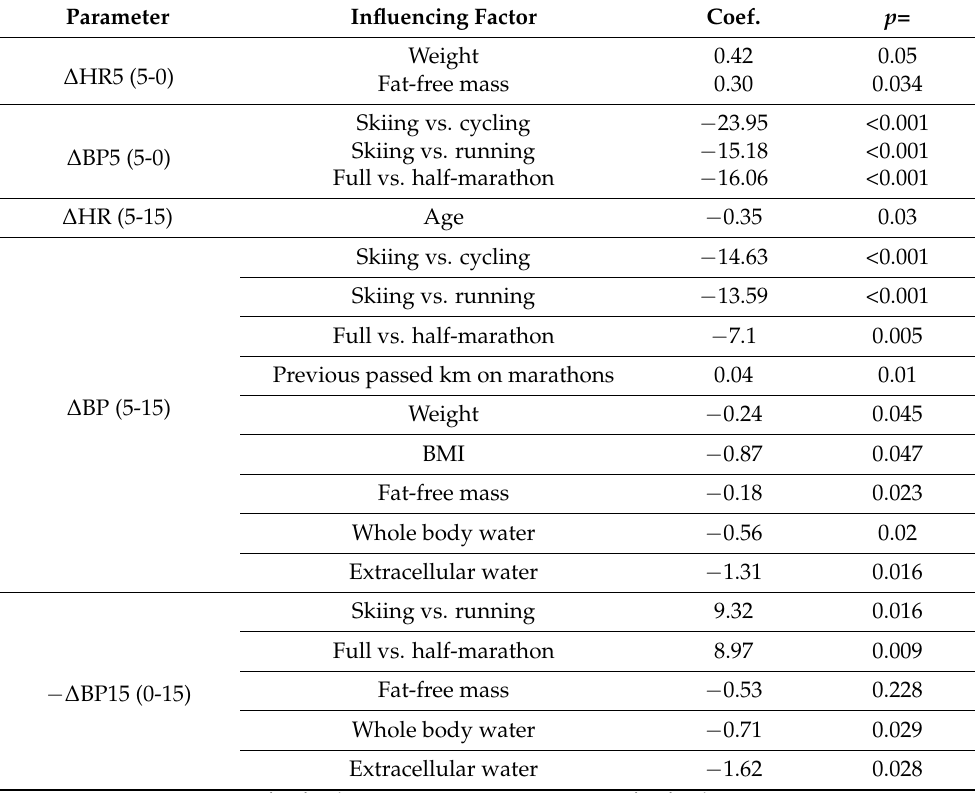
Table 3. Parameters influencing the BP and HR parameters after finishing, during relax time, and recovery after relax time (results of linear regression analysis). Parameter Influencing Factor Coef. p